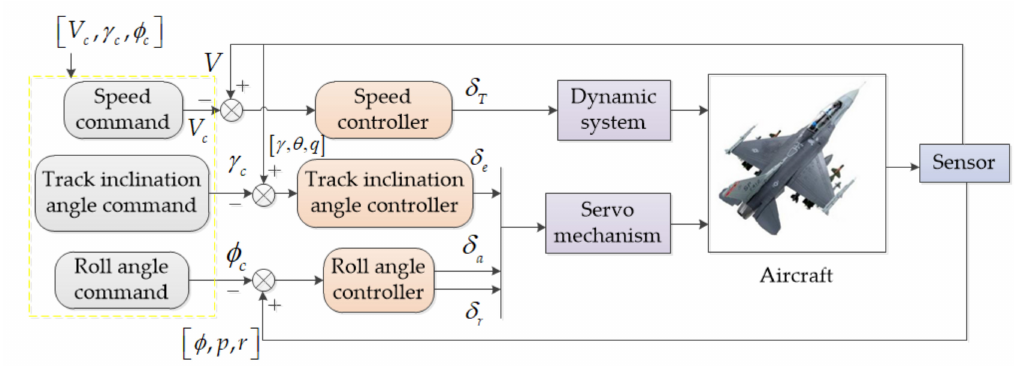
Figure 2. Flight control system.